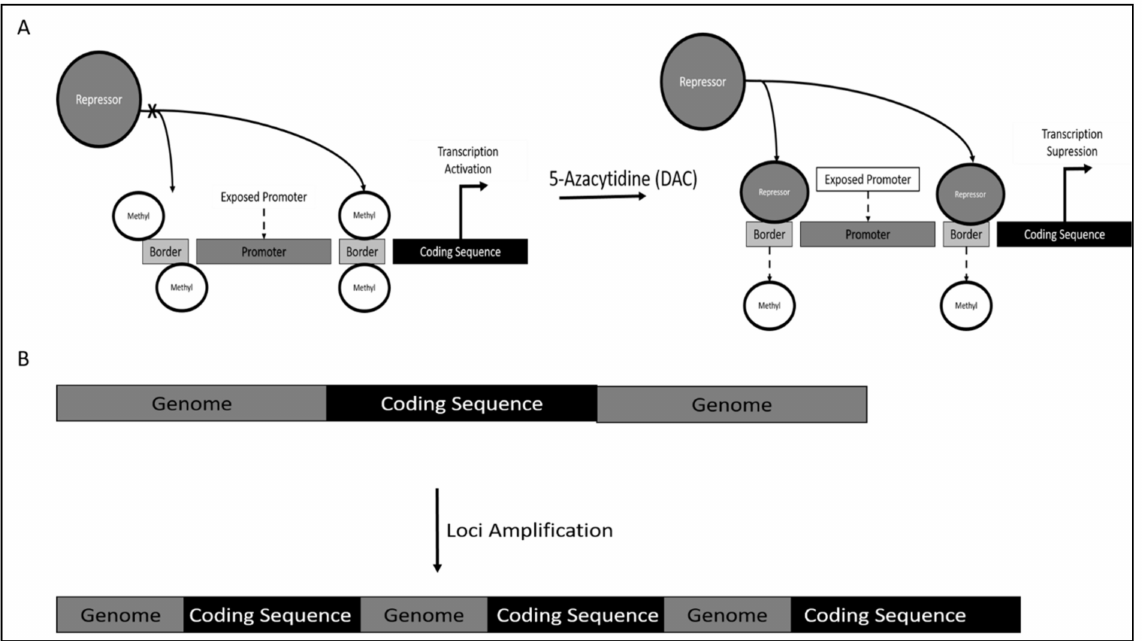
Figure 1. ( A ) Epigenetic regulation of TERT via promoter border region methylation. ( B ) Loci amplification of TERT gene resulting in an increase in copy